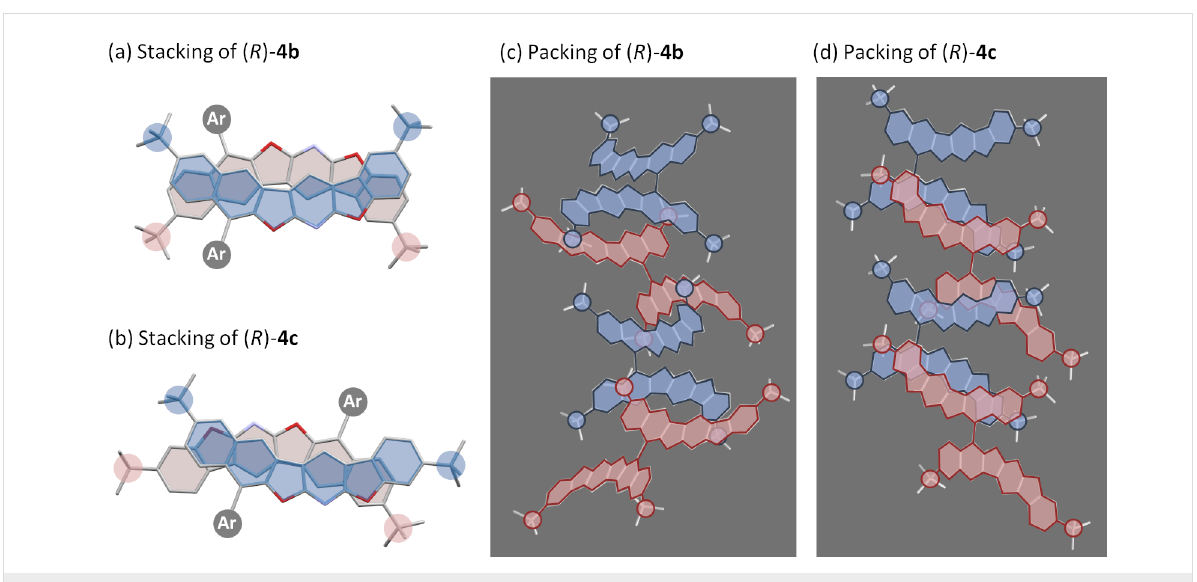
Figure 5: Intramolecular stacking structures of 4b and 4c .